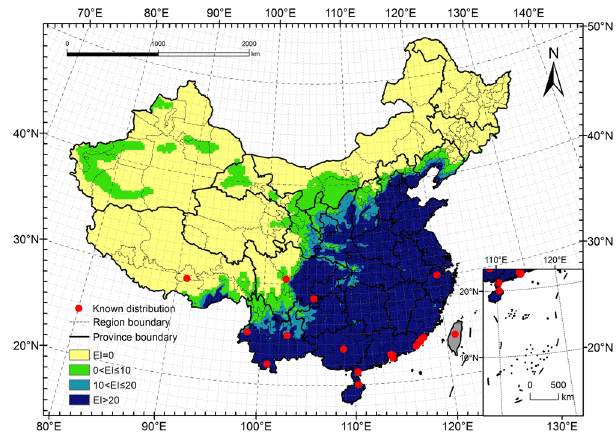
Figure 5. Potential distribution for Euwallacea fornicates under the future climate (2011–2040). The future climate data were derived from CSIRO-Mk3-6-0 models (RCP8.5). Yellow regions indicatef unsuitable habitats (EI = 0), green regions indicated marginally favorable habitats (0 < EI ≤ 10), turkish blue regions indicated favorable habitats (10 < EI ≤ 20) and deep blue regions indicate highly favorable habitats (EI > 20). The red points showed the locations of the known distribution in China. The grey regions (Taiwan) were not analyzed. The CLIMEX results were exported into GIS software (ArcGIS for Desktop, Software Version 10.2, http:// resources.arcgis.com/en/home/) to generate the map in this figure.